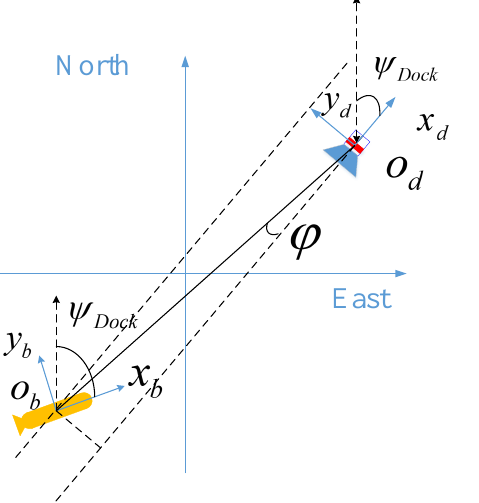
Figure 8. The terminal guidance diagram of an AUV in the northeast sky coordinates. The angle ∆ ϕ being equal to 0 means that the AUV tracks the line connecting the triaxial-coil magnetometer and the origin point of the fixed coordinate, and it will finally enter the DS. The docking control strategy to adjust the angle ∆ ϕ to 0 by adjusting the horizontal rudder of the AUV is shown in Figure 9. Since the DS is fixed underwater, the yaw angle of the DS will not change. The AUV obtains the current yaw deviation by the compass, then calculates the current coordinates and direction angle in the fixed-coordinate system based on the data from the triaxial-coil magnetometer. The difference ∆ e between the angle ∆ ϕ and 0 is the control quantity of the system. It is changed into the required steering angle δ r by using the PID controller, and then the AUV is controlled to continuously track the origin of the DS in terminal docking guidance.